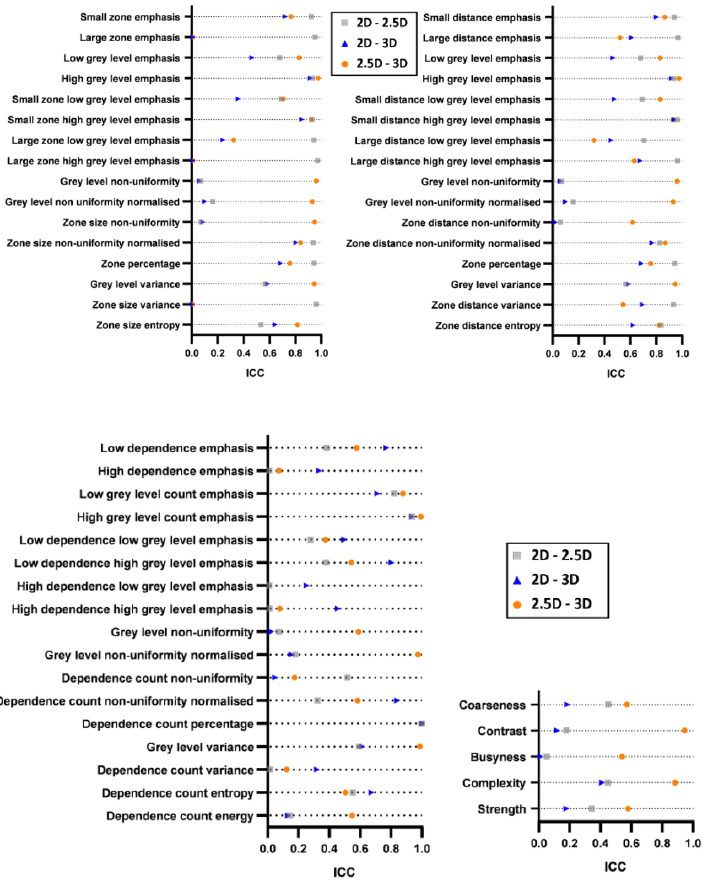
Figure 6. Pairwise ICC for each of GLSZM ( top-left ), GLDZM ( top-right ), NGLDM ( bottom-left ) and NGTDM ( bottom-right ) features extracted from three aggregation strategies (2D, 2.5D, 3D), denoted as 2D-2.5D, 2D-3D, and 2.5D-3D.